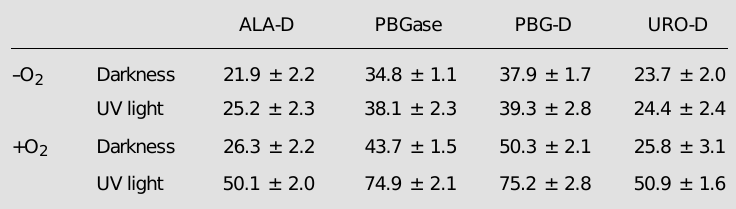
Table 2 - Percentage of enzyme inactivation induced by URO I. Effect of the presence of